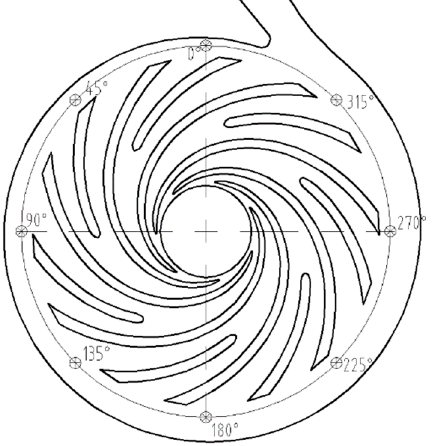
Figure 5. Position of the virtual monitor points.